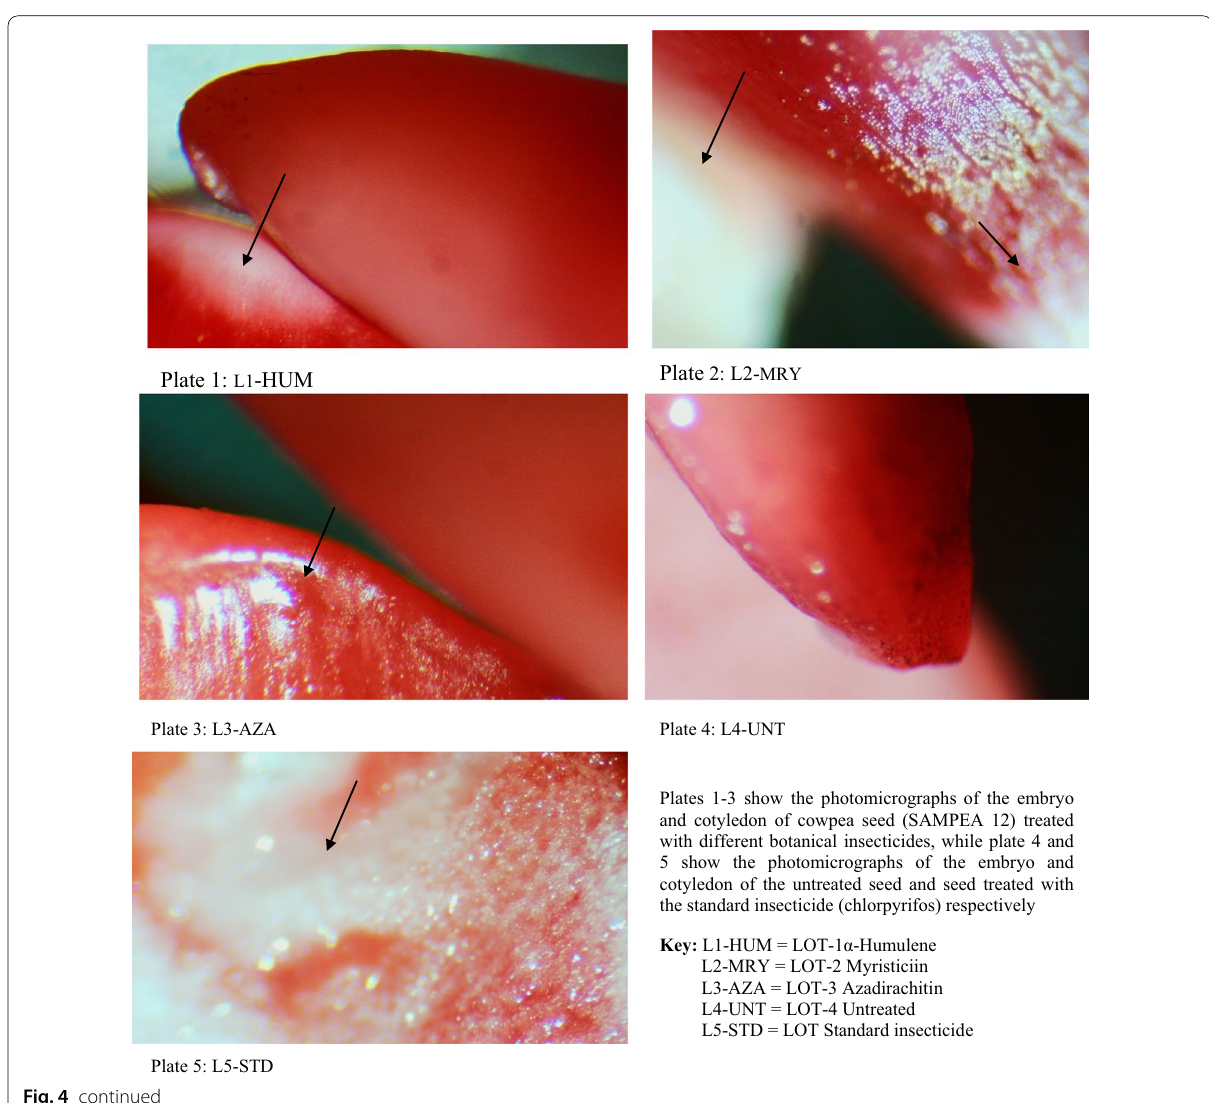
Plates 1-3 show the photomicrographs of the embryo and cotyledon of cowpea seed (SAMPEA 12) treated with different botanical insecticides, while plate 4 and 5 show the photomicrographs of the embryo and cotyledon of the untreated seed and seed treated with the standard insecticide (chlorpyrifos) respectively Key: L1-HUM = LOT-1α-Humulene L2-MRY = LOT-2